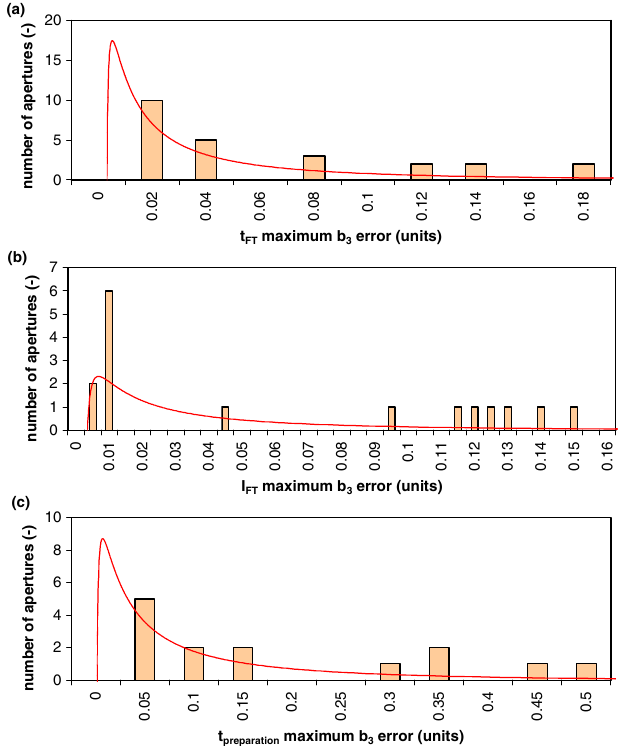
FIG. 17. (Color) (a), (b), (c) Histograms and log-normal distri- bution of the maximum residual error for I respectively, between the scaled harmonic decay and the average harmonic decay of the magnet set analyzed.